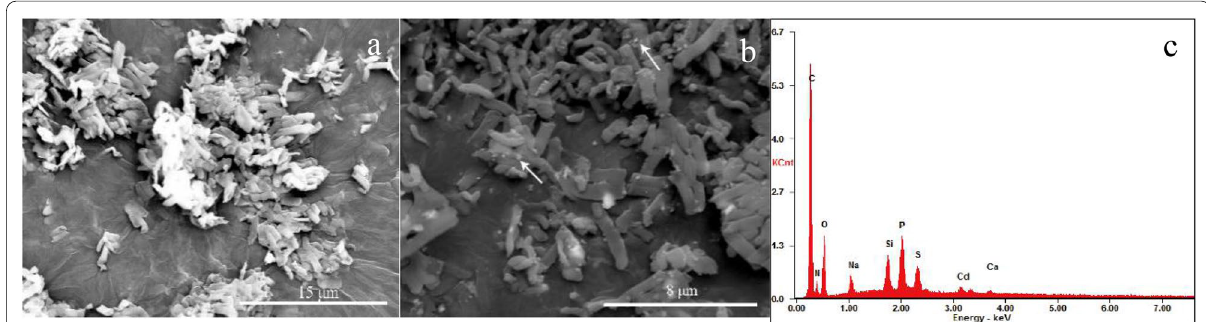
Fig. 2 The SEM image and its corresponding EDS spectrum of C09 after treatment with CdS NPs. a Without CdS NPs; b with CdS NPs; c EDS of C09 with CdS NPs